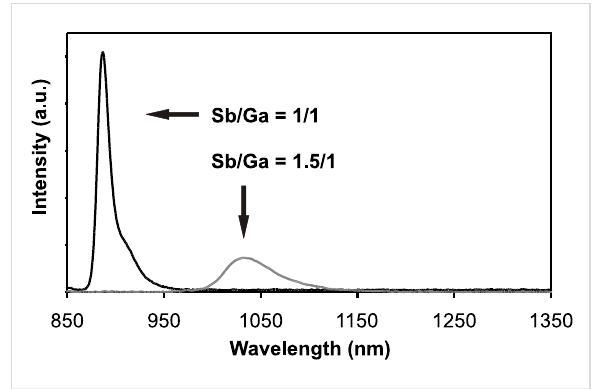
Figure 2: PL spectra of GaSb dots grown on GaAs with two different V/III ratios of 1.5/1 and 1/1, respectively, at a growth temperature of T = 527 °C and a nominal coverage of 3 ML.